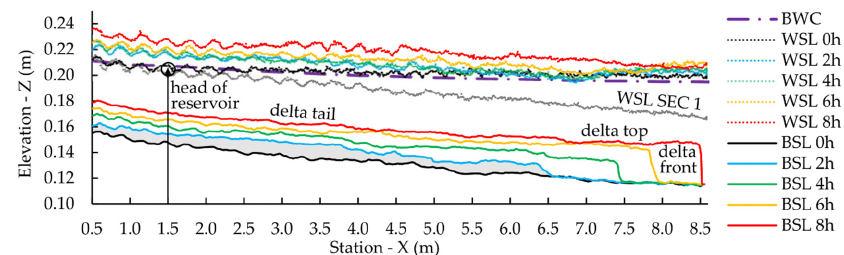
0.7 × HQ 1 during turbine operation. The grey line represents the water surface profile of the free- flowing section which corresponds to the bed levels at hour 0 (black line). The head of the reservoir is located at X = 1.5 m. Different areas of the delta formation, namely “delta front”, “delta top” and “delta tail”, are indicated. WSL = water surface levels, BSL = bed surface levels, BWC =